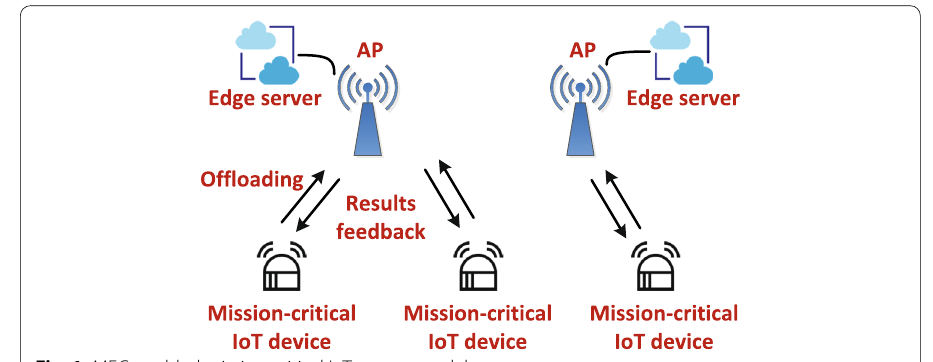
Fig. 1 MEC-enabled mission-critical IoT system